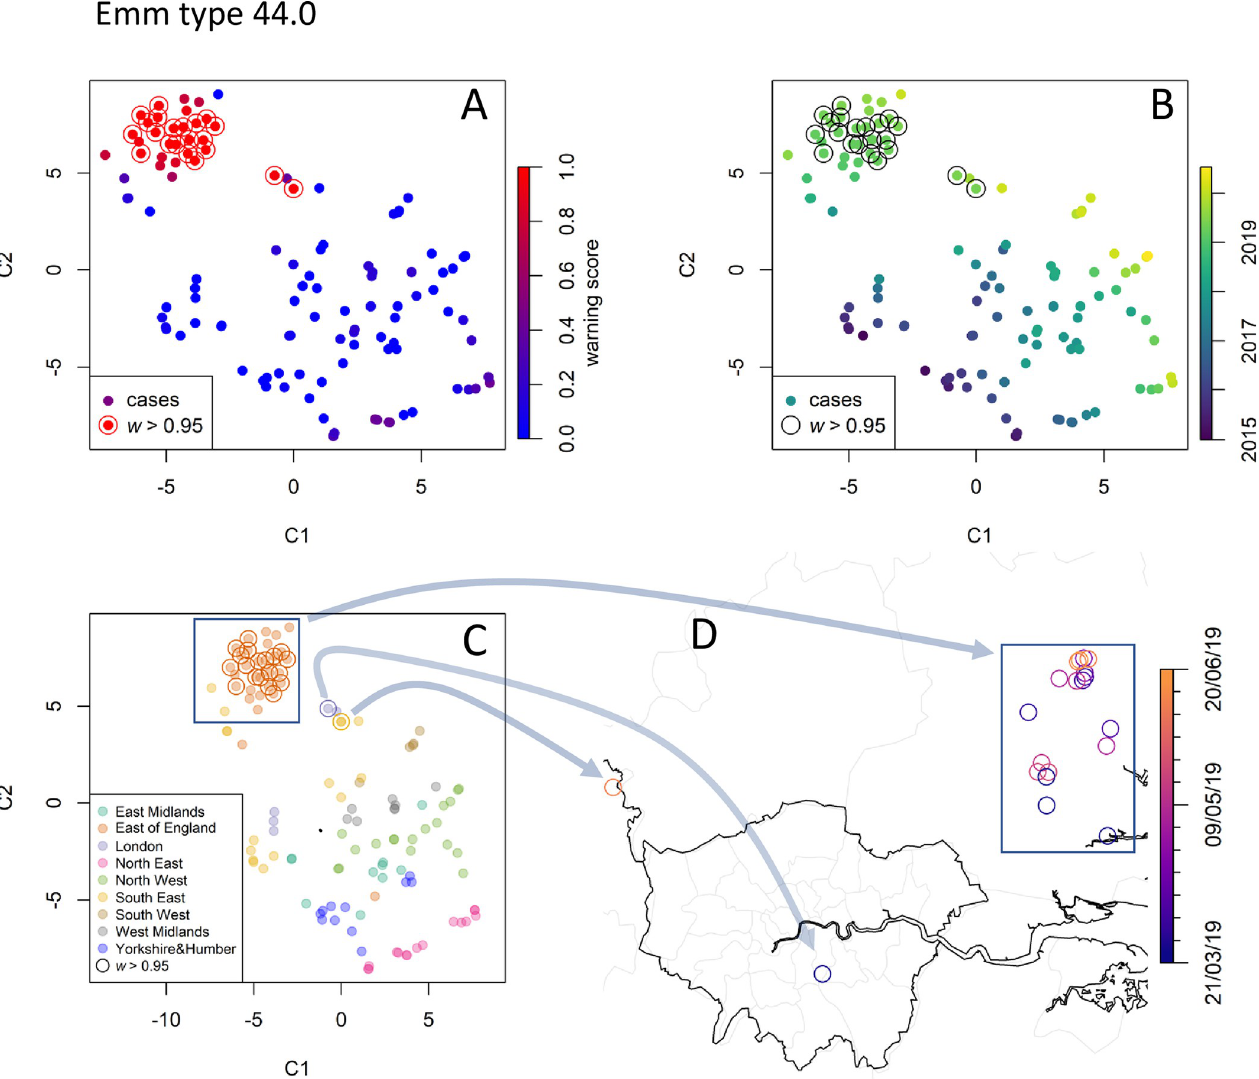
Fig 9. Data point embedding and cluster analysis for emm type 44.0. Keys as in Fig 7. The analysis detects a compact cluster localised in the East of England in 2019 (rectangle), with its embedded points mapped to their geographical location by the arrows. Map created with Sf [55] using shapefiles from the GADM database (https://gadm.org/maps/GBR_1.html) and the Ordnance Survey Data Hub